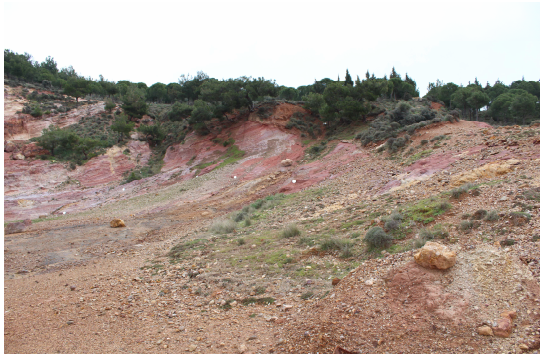
Figure 1. General view of the geothermal site